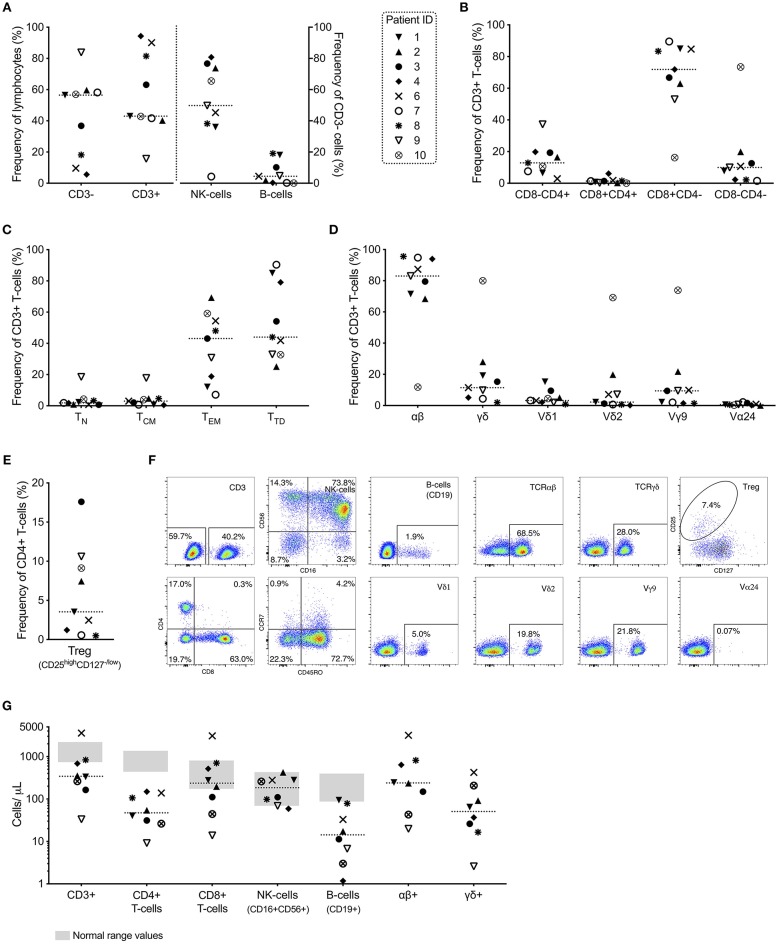
Characterization of peripheral blood mononuclear cells 3–5 weeks (n = 9) after infusion of αβ T-cell depleted stem cell booster. (A) Major lymphocyte populations: T-cells (CD3+), B-cells (CD19+) and NK-cells (CD56+CD16+); (B) CD4 and CD8 T-cell subsets; (C) memory/maturation status of total (CD3+) T-cells; naïve (TN, CCR7+CD45RO-), central memory (TCM, CCR7+CD45RO+), effector memory (TEM, CCR7-CD45RO+) and terminally differentiated (TTD, CCR7-CD45RO-); (D) αβ T-cells, γδ T-cells and subsets of γδ T-cells and invariant NKT-cells (all gated on total T-cells); and (E) regulatory T-cells (CD25highCD127−/low on CD4+ T-cells) are presented along with (F) representative example plots from all indicated populations from patient 2. (G) Absolute numbers of T-, B- and NK-cells (with gray areas representing the normal range determined for healthy adult patients) and αβ+ and γδ+ cells, respectively (n = 8). Absolute numbers were calculated by multiplying the frequency of the subsets (gated from total alive cells) with the white blood count determined at 4 weeks post-infusion of αβ T-cell depleted cell product.